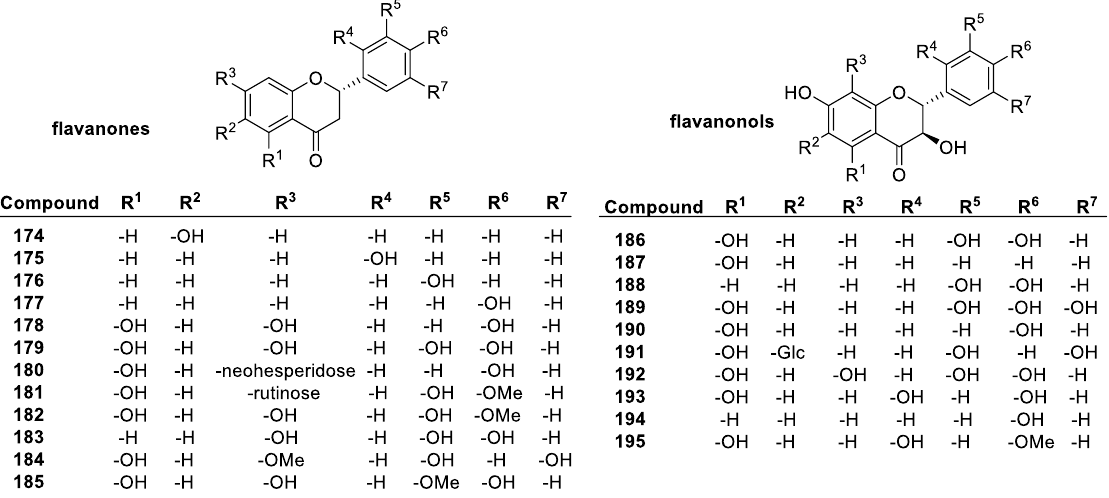
Figure 13. Representative examples of flavan-3-ols and anthocyanidins/anthocyanins with antiox- idant effect. Figure 14. Representative examples of isoflavonoids with antioxidant effect. Although more hydroxyl groups increase antioxidant activity, there are limitations to this. Studies have shown that a third hydroxyl group in the B-ring does not increase antioxidant efficiency. Quercetin ( 161 ) and myricetin ( 163 ) have almost identical struc- tures, but myricetin has an additional hydroxyl group at position 5′ , and lower TEAC activity. Other methods, however, e.g., DPPH, electron spin resonance (ESR) spectros- copy, and the FCR total phenolic content assays, show higher activity for myricetin [143]. One of the most important structural patterns for the antioxidant activity of flavo- noids is the 3′,4′ B -ring OH substitution. Referred to as a catechol group after the com-